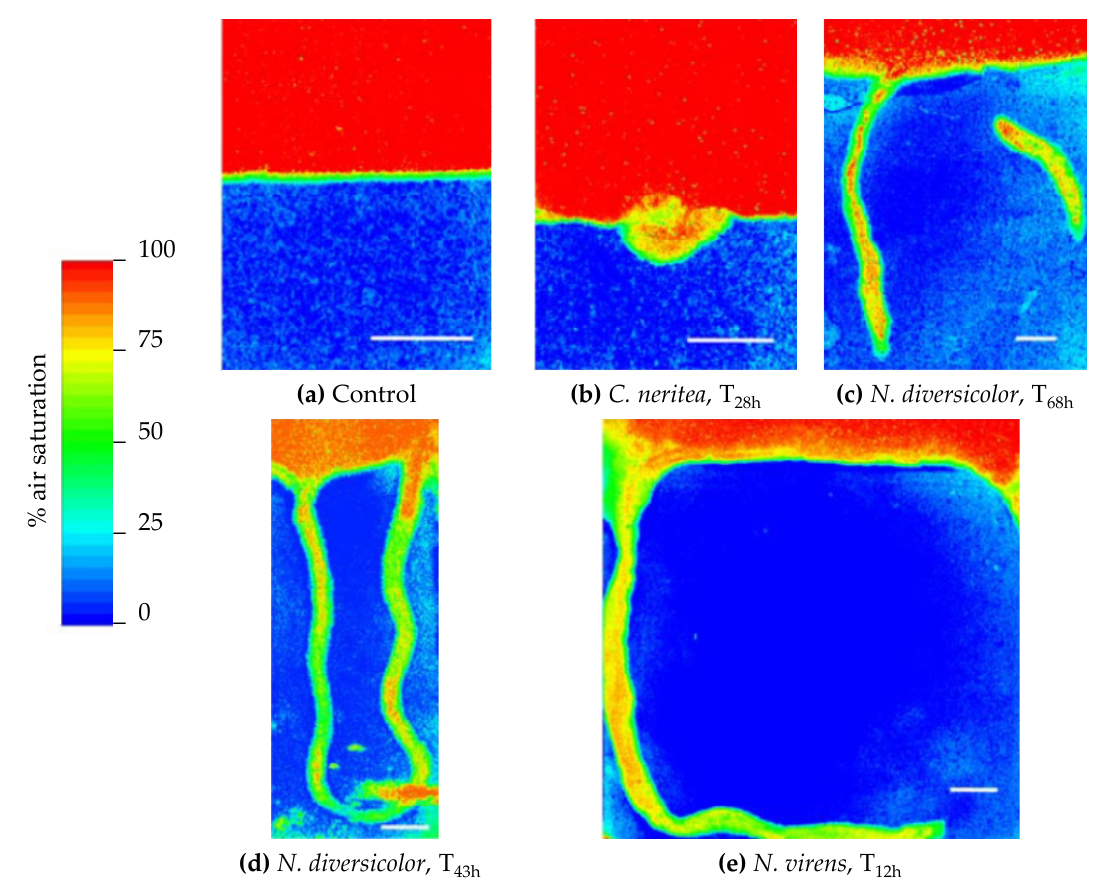
Figure 6. Examples of oxygen distribution in sediments. The gray-scale images were converted into false color. ( a ) Control without organism (resolution: 570 × 570 µm); ( b ) Cyclope neritea (resolution: 610 × 610 µm); ( c ) Nereis diversicolor (resolution: 500 × 500 µm); ( d ) N. diversicolor (resolution: 790 × 790 µm); ( e ) Nereis virens (resolution: 770 × 770 µm). Times at which the pictures were acquired are indicated [116].